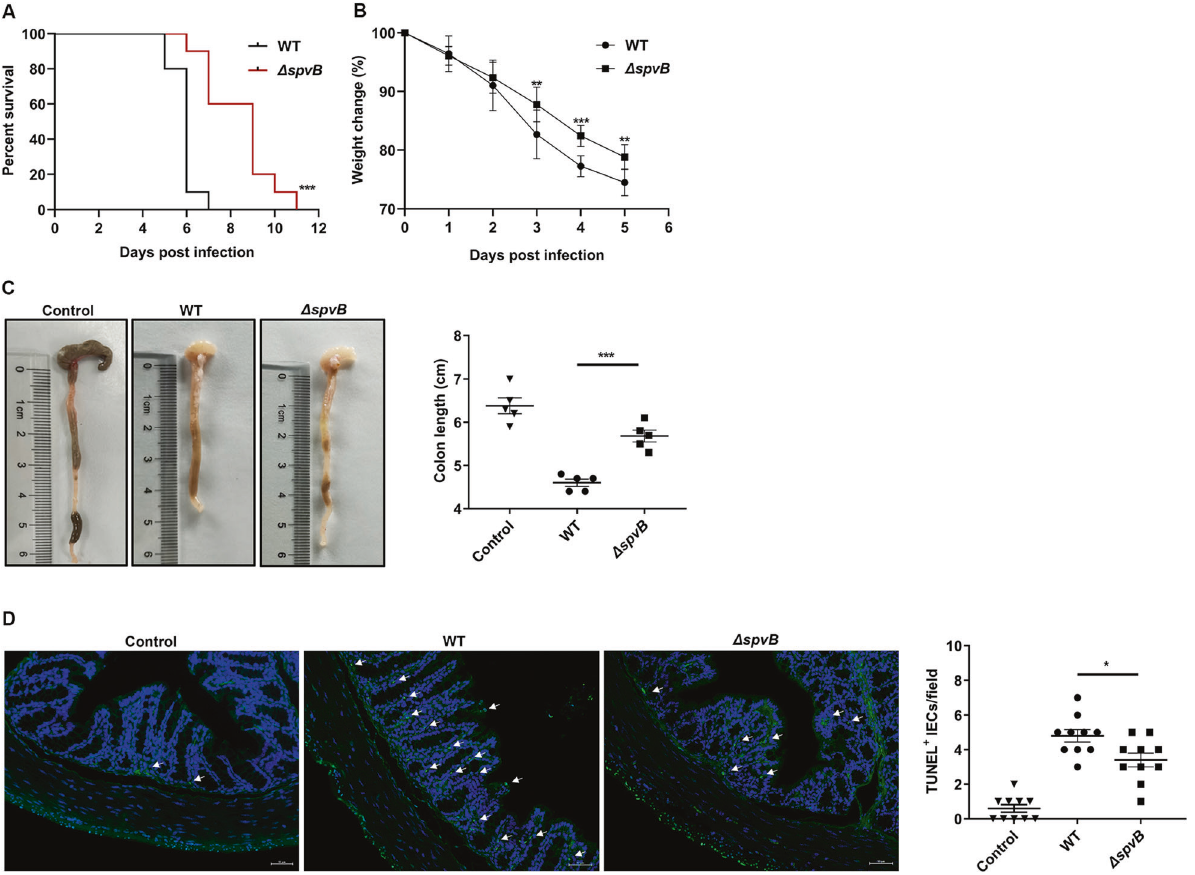
Fig. 5 SpvB promotes the pathogenicity of Salmonella and induces colon cell death in vivo. A , B C57BL/6 mice were treated with streptomycin 24 h prior to oral infection with the WT or Δ spvB S . Typhimurium strain (1 × 10 7 CFUs). A Survival curves, n = 10 mice per group. B Body weight changes, n = 10 mice per group. C , D C57BL/6 mice were treated with streptomycin 24 h prior to oral infection with the WT or Δ spvB S . Typhimurium strain (1 × 10 8 CFUs) and analyzed at 48 h. C Colon length and representative photographs of colons, n = 5 mice